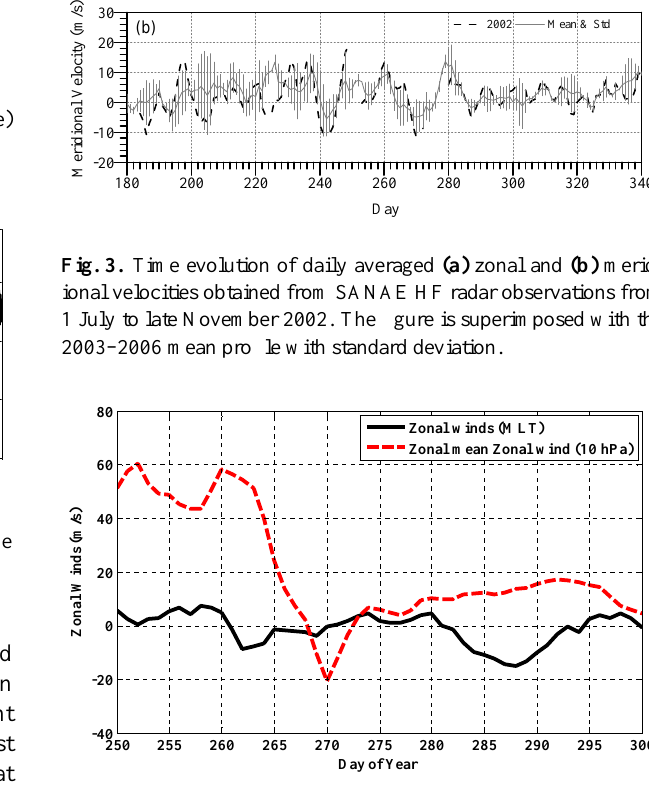
zonal wind observations from SANAE HF radar (for ∼ 94 km MLT height) are superimposed with a solid black line. The SANAE HF radar data is smoothened by a 4-day running mean. The figure shows that the zonal wind started to re- verse (became westward) in the MLT region on the 261th 2002-Julian day (18 September), i.e., about a week earlier than the reversal of the zonal wind in the polar stratosphere at ∼ 10 hPa pressure level. The reversal in the MLT reaches a maximum magnitude of about − 10 m/s on the 263th day (20 September 2002). The MLT zonal winds reversal lasted for a